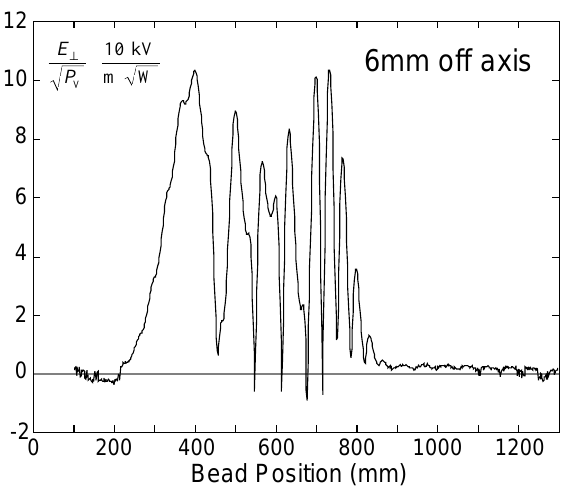
FIG. 9. Measurement: transverse (cid:69) field of mode #16.